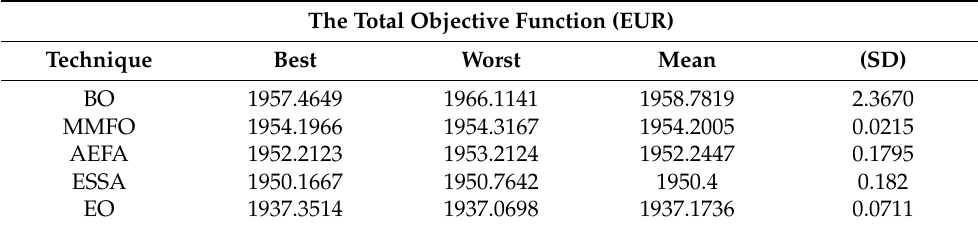
Figure 5. Convergence characteristic of the EO for all scenarios in Case 2. Table 7. Comparison of the statistical results of the objective function in Scenario 1. Table 6. The best results obtained using the EO for the EM problem for Scenario 3 (Case 2).